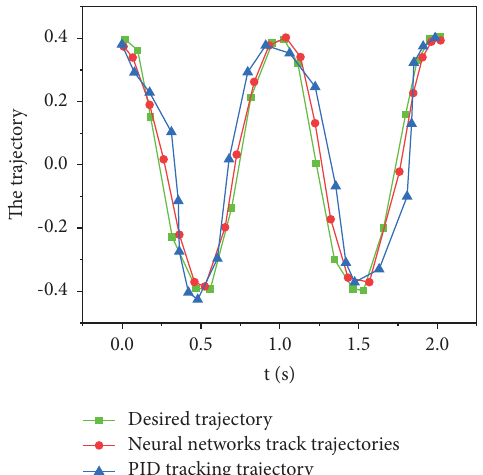
Figure 5: Movement trajectory of robotic arm 3 (with external interference).